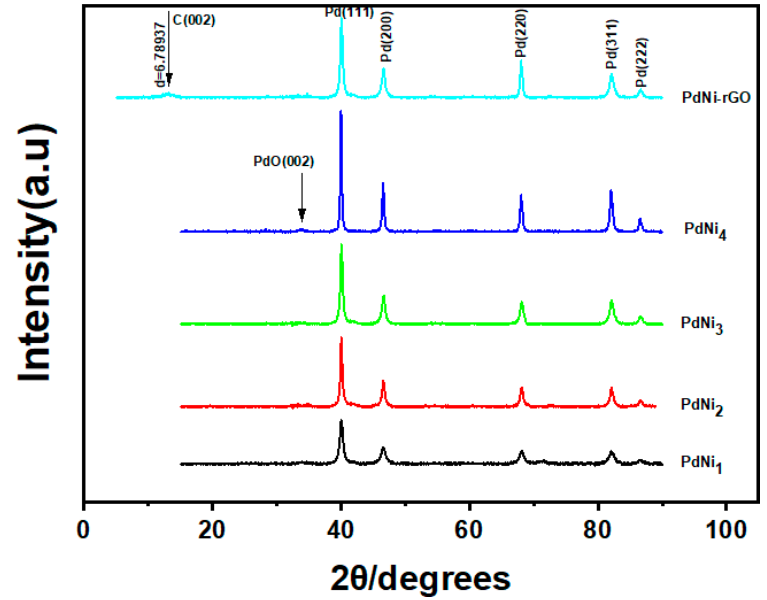
Figure 2. Scanning electron microscopy (SEM) images for the synthesized binary palladium PdNi x